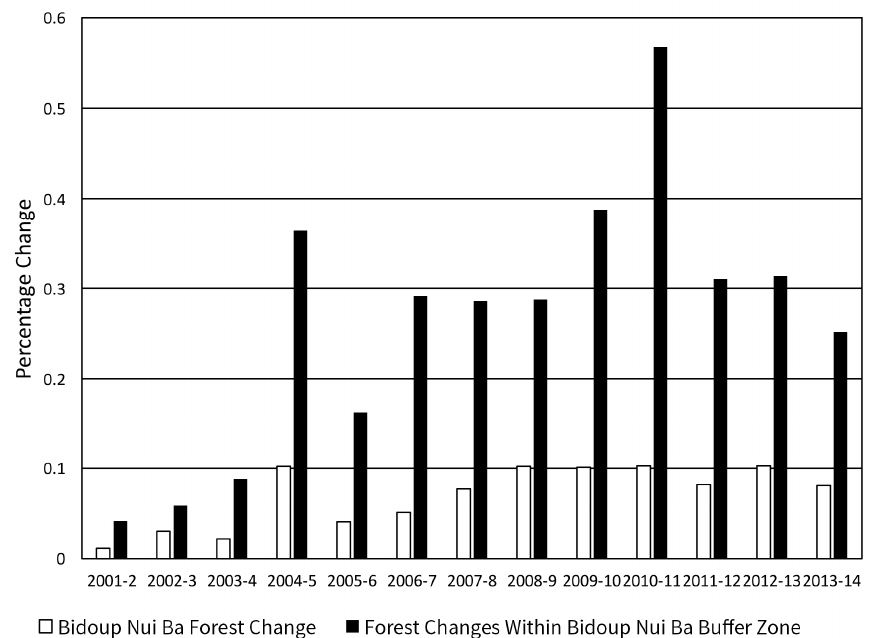
Figure 11. Comparison between forest change due to disturbance in Bidoup Nui Ba National Park and buffer zone regions. Disturbance changes represent loss of greenness as determined using NDVI difference threshold values between adjacent years.